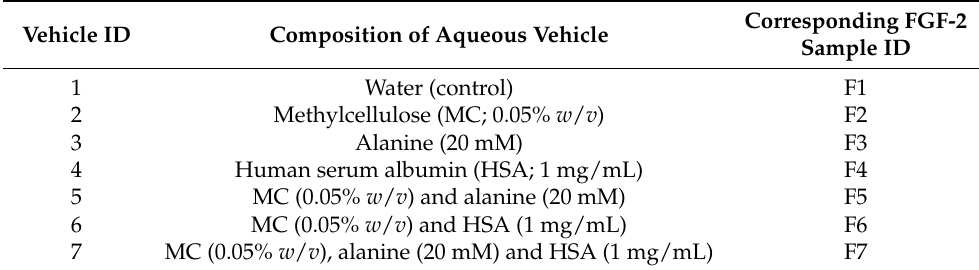
Table 3. Identification key for blank vehicles and corresponding FGF-2 solutions (770 ng/mL) prepared using the